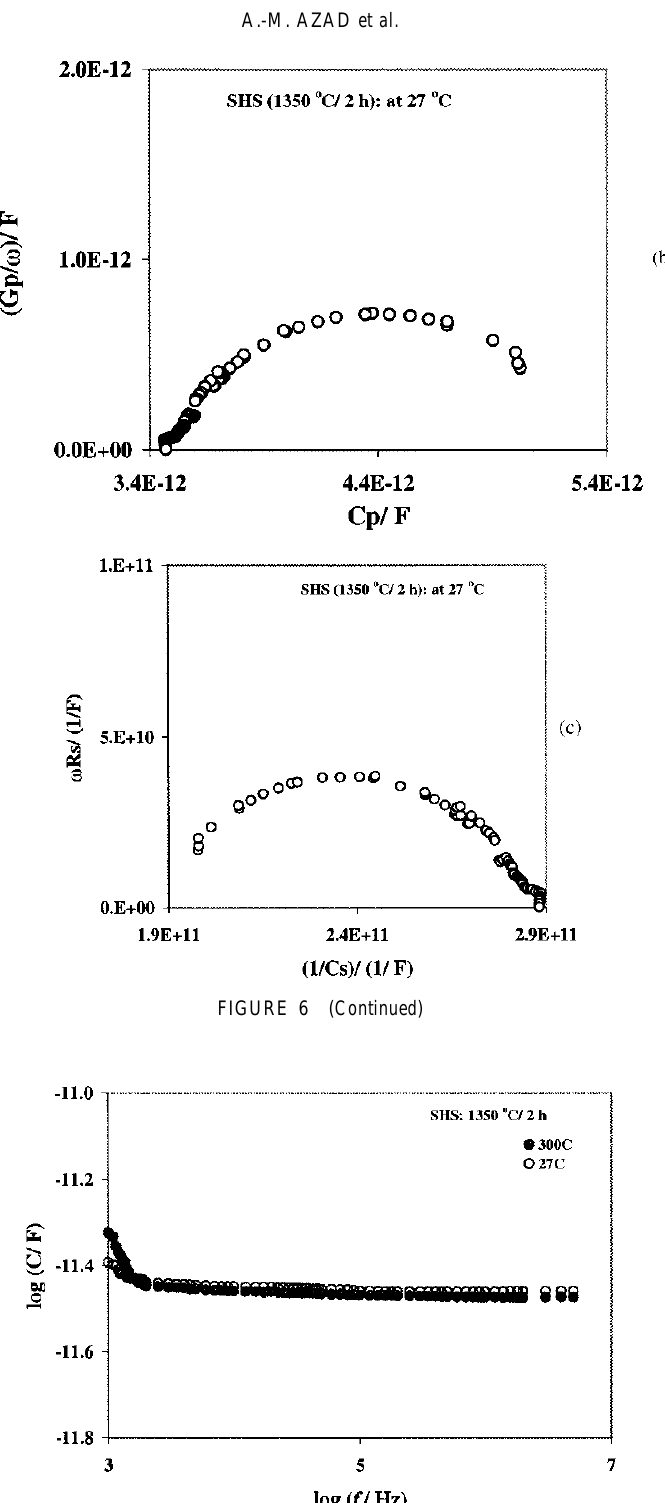
FIGURE 7 Frequency dependence of capacitance of the SHS-derived SrSnO 3 samples sintered at 1350 (cid:1) C for